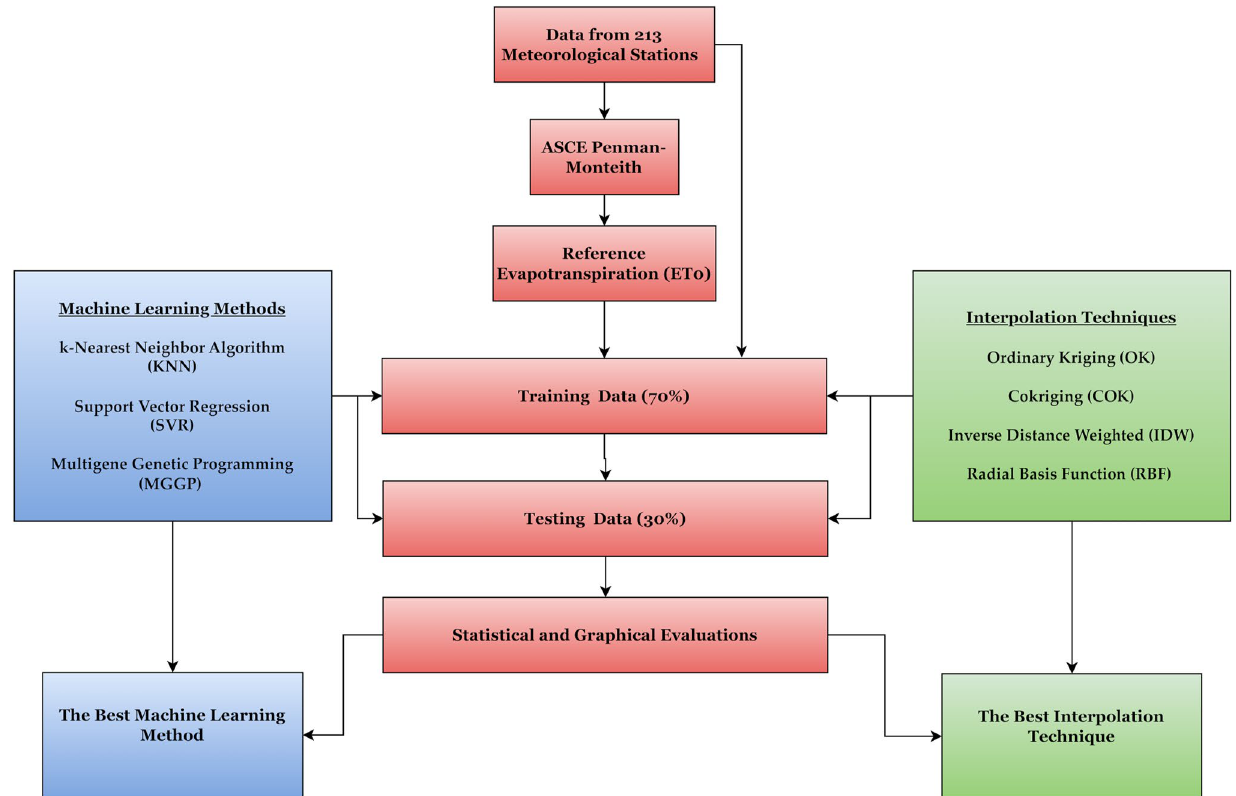
Fig. 2 Research flowchart of the